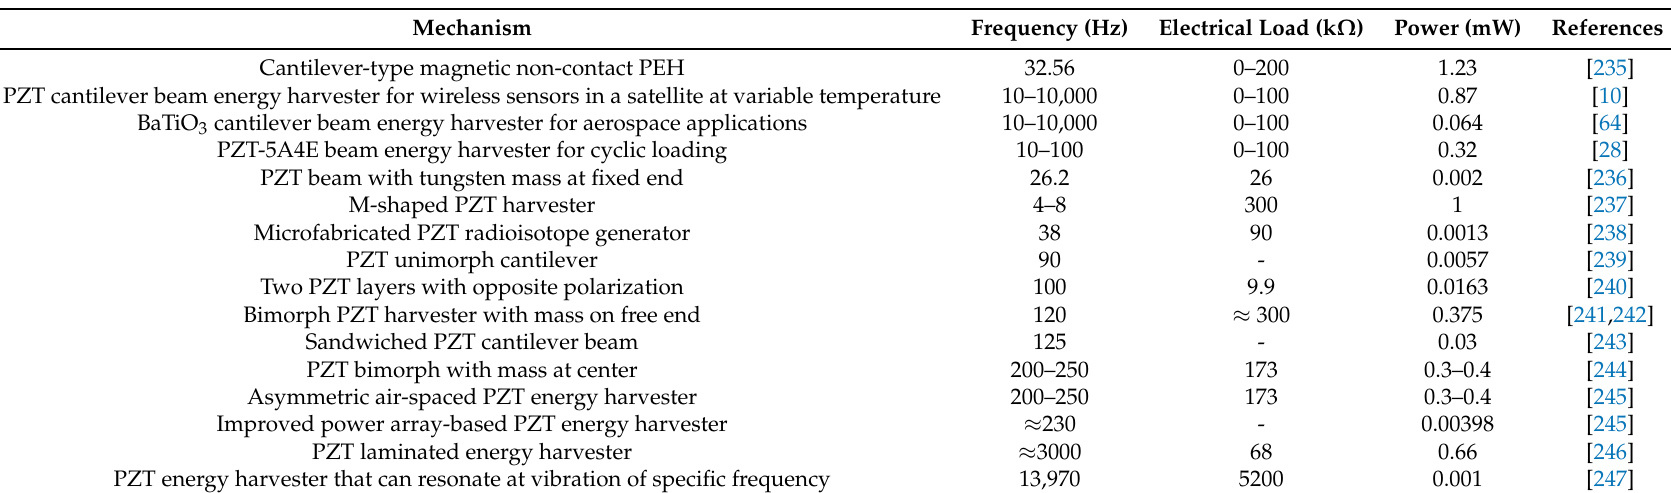
Table 5. Comparison of various cantilever-based